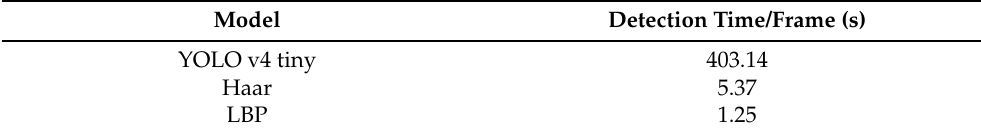
Table 2. The detection time of different